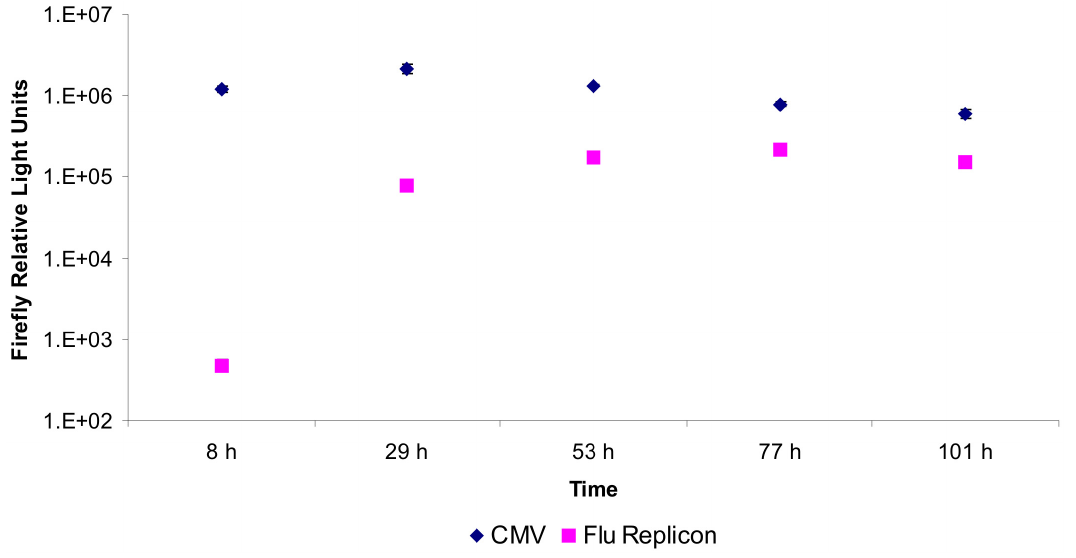
Figure 6. Time course of firefly luciferase expression. HEK-293 cells either tranfected with pcDNA-luc (CMV) or with the influenza replicon and pMono-lucNS (Flu Replicon) were monitored over a period of 101 hours by luciferase assay. Data represents arithmetic mean values and standard deviation.